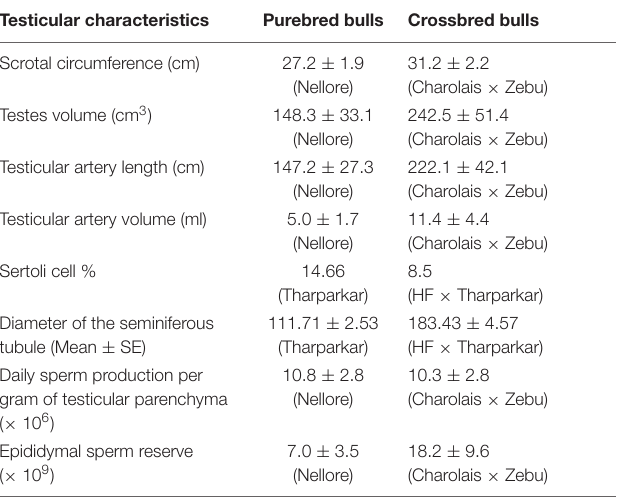
TABLE 4 | Testicular characteristics between purebred and crossbred bulls (based on the data from Brito et al., 2004; Tripathi et al., 2015). Testicular